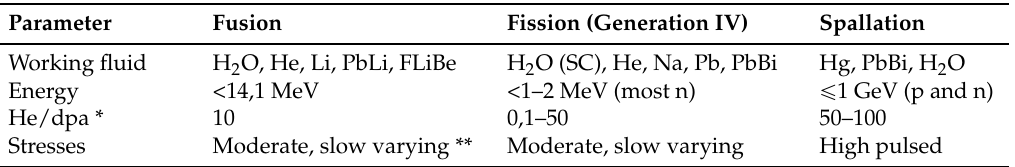
Table 3. Summary of operating parameters for fusion, fission and spallation facilities. This table is taken from